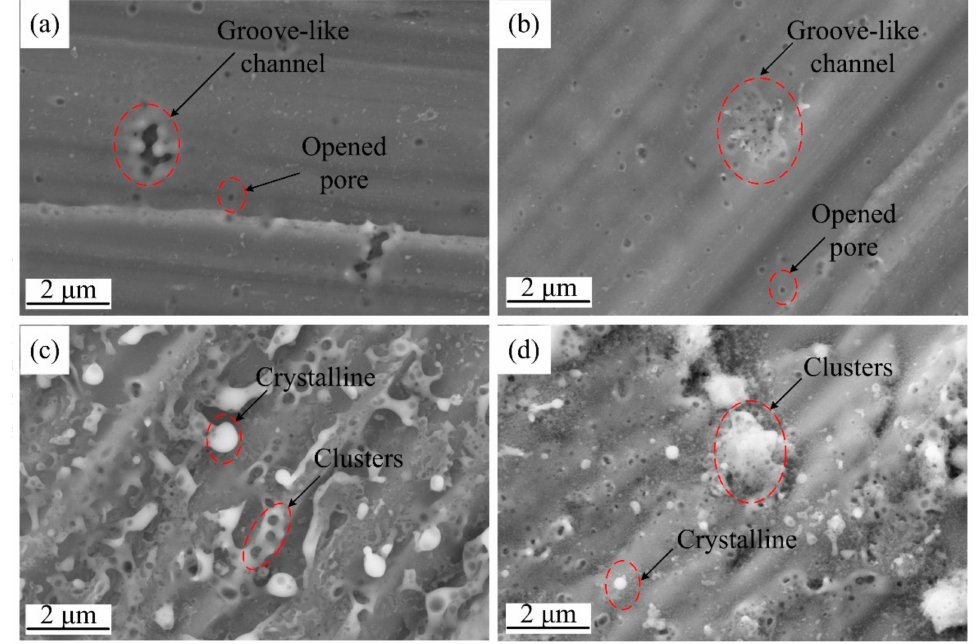
Figure 6. SEM images of micro-electrodes obtained in di ff erent conditions, ( a ) anodizing with 400 V / 100 µ s pulse, ( b ) anodizing with 400 V / 500 µ s pulse, ( c ) anodizing with 400 V / 2 ms pulse, ( d ) anodizing with 400 V / 5 ms